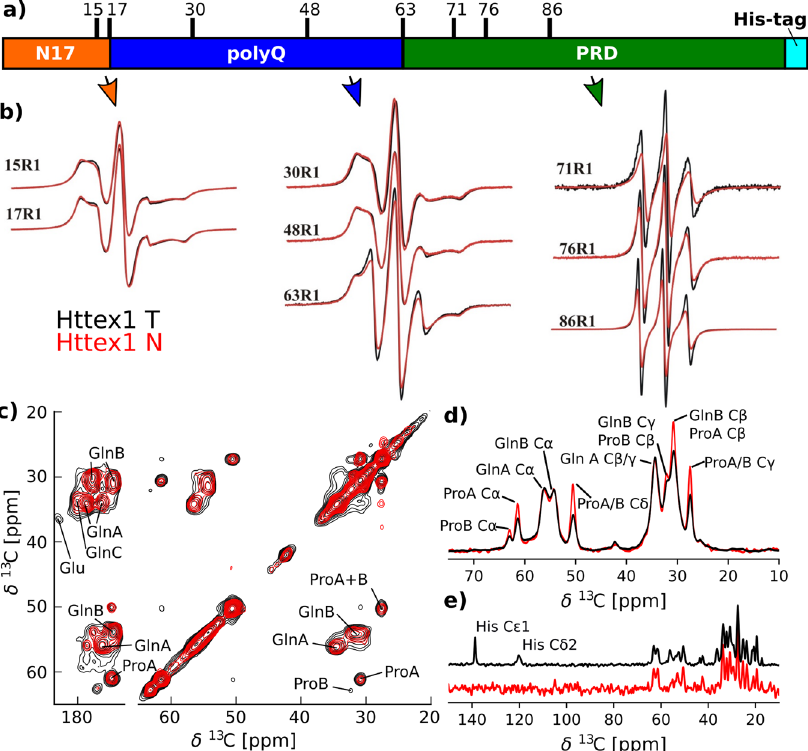
Fig. 2 EPR and solid-state NMR spectra indicate a more dynamic PRD in the T- fi brils compared to the N- fi brils. a Domain structure of HTTex1 highlighting the N17 region in orange, the polyQ domain in blue, the PRD in green, and the C-terminal His-tag in cyan. The residues that were spin-labeled for CW measurements are indicated. b CW EPR spectra of T- and N- fi brils are shown in black and red, respectively. The residue number of the spin label is indicated. The spectra of N- and T- fi brils overlap very well for all positions within the N17 and polyQ region indicating that they have the same structure and dynamics. However, the spectra of the T- fi brils are narrower for the last Q in the polyQ region (63R1) and all sites within the PRD indicating increased dynamics in this region compared to N- fi brils. c The 2D DARR 13 C- 13 C spectra of N- and T- fi brils overlap very well, indicating that the static fi bril core of both fi brils has a very similar structure. The spectra of N- and T- fi brils are shown in red and black, respectively. Both spectra were recorded at 0 °C, 25-kHz MAS with 50-ms mixing time. The spectrum of the T- fi brils was previously published as Fig. 2 by Isas et al. 8 . d 1D 13 C cross polarization (CP) spectra, which are sensitive to more static residues. Spectra of N- fi brils (red) and T- fi brils (black) were normalized to their Gln C α intensities. The amino acid assignments of the lines are indicated. The higher intensities of the proline lines in the spectra of the N- fi brils indicate that this domain is more static in this fi bril type. e Refocused INEPT spectra, which detect highly dynamic residues, were normalized according to the spectra shown in ( d ). The assignment of the His resonances that were detected for the T but not for the N- fi brils is